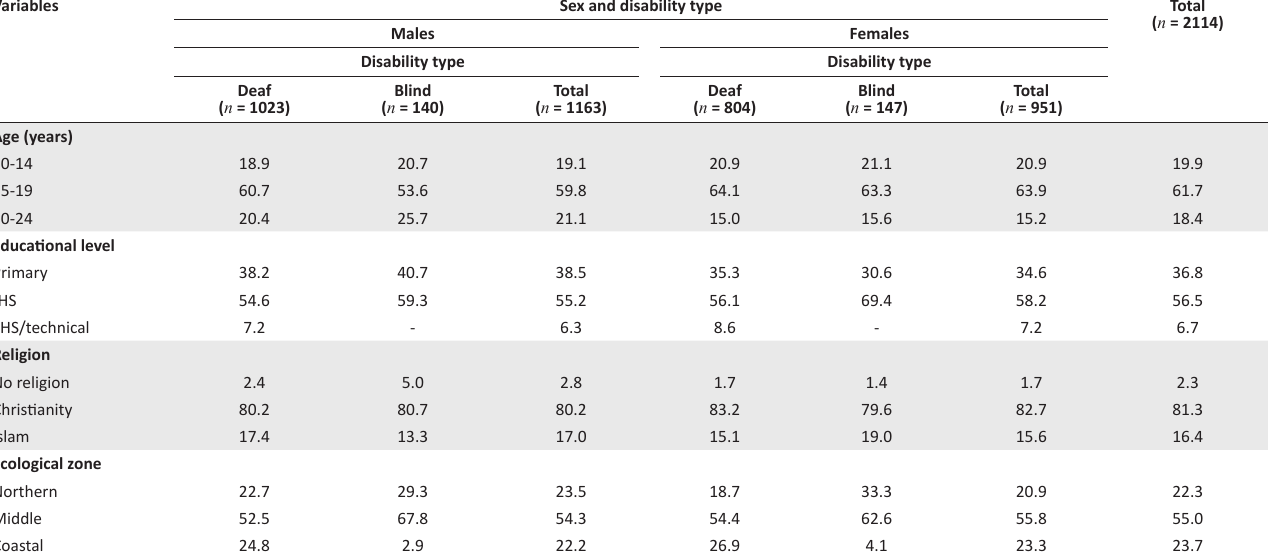
TABLE 2: Distribution of socio-demographic characteristics of respondents by sex and type of disability.